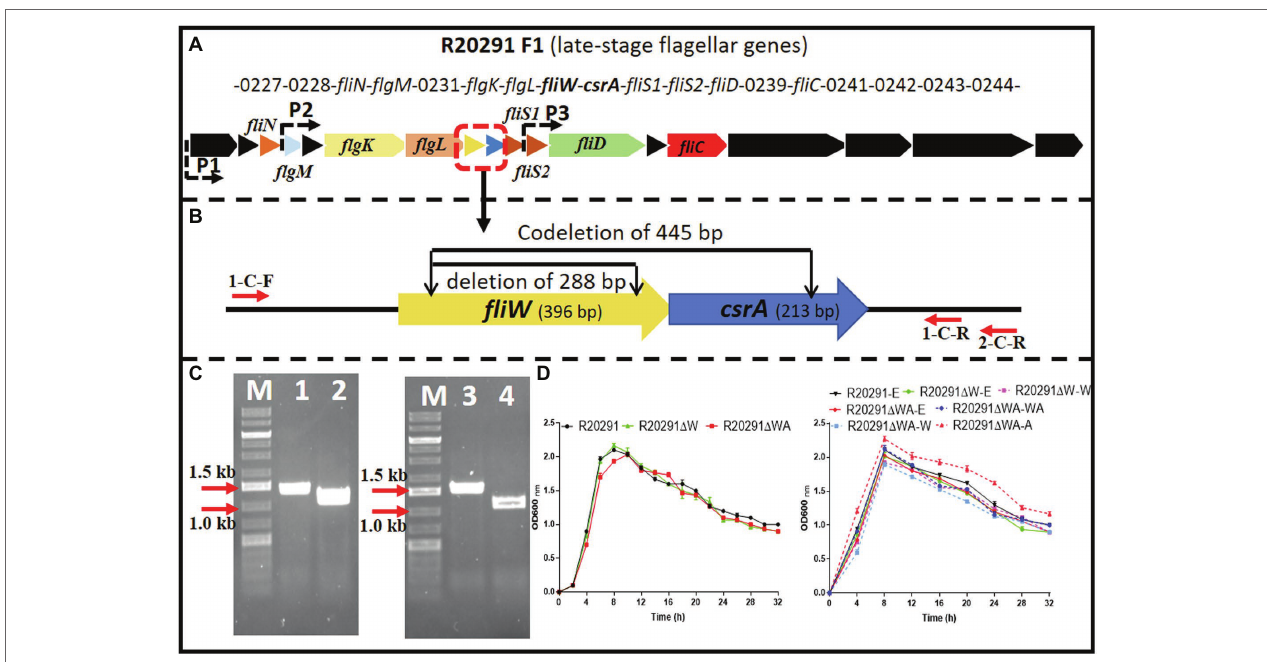
FIGURE 1 | R20291 late-stage flagellar genes (F1) and fliW and fliW - csrA deletion. (A) Schematic representation of late-stage flagellar genes (F1). Dotted arrows (P1, P2, and P3) indicate the potential promoters in F1. (B) Deletion of fliW and fliW - csrA genes. 1-C-F/R were used to verify fliW deletion, and 1-C-F and 2-C-R were used to test fliW - csrA codeletion. (C) Verification of fliW and fliW - csrA deletions by PCR. M, DNA ladder; 1, R20291 genome as PCR template; 2, R20291 ∆ W genome as PCR template; 3, R20291 genome as PCR template; and 4, R20291 ∆ WA genome as PCR template. (D) Growth profile of parent strain and gene deletion mutants. Experiments were independently repeated thrice. Bars stand for mean ± SEM. One-way ANOVA with post hoc Tukey test was used for statistical